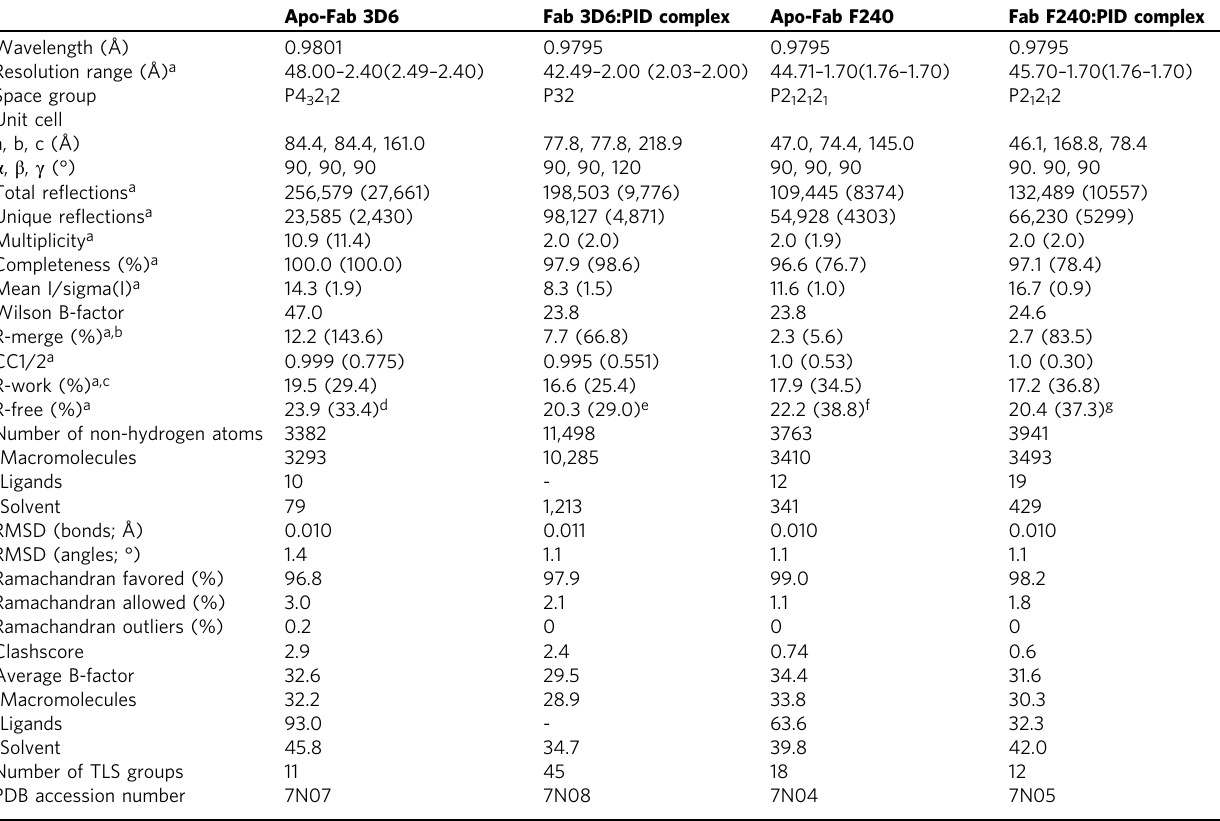
Table 1 Data collection and re fi nement statistics for Fab 3D6 and Fab F240 crystal